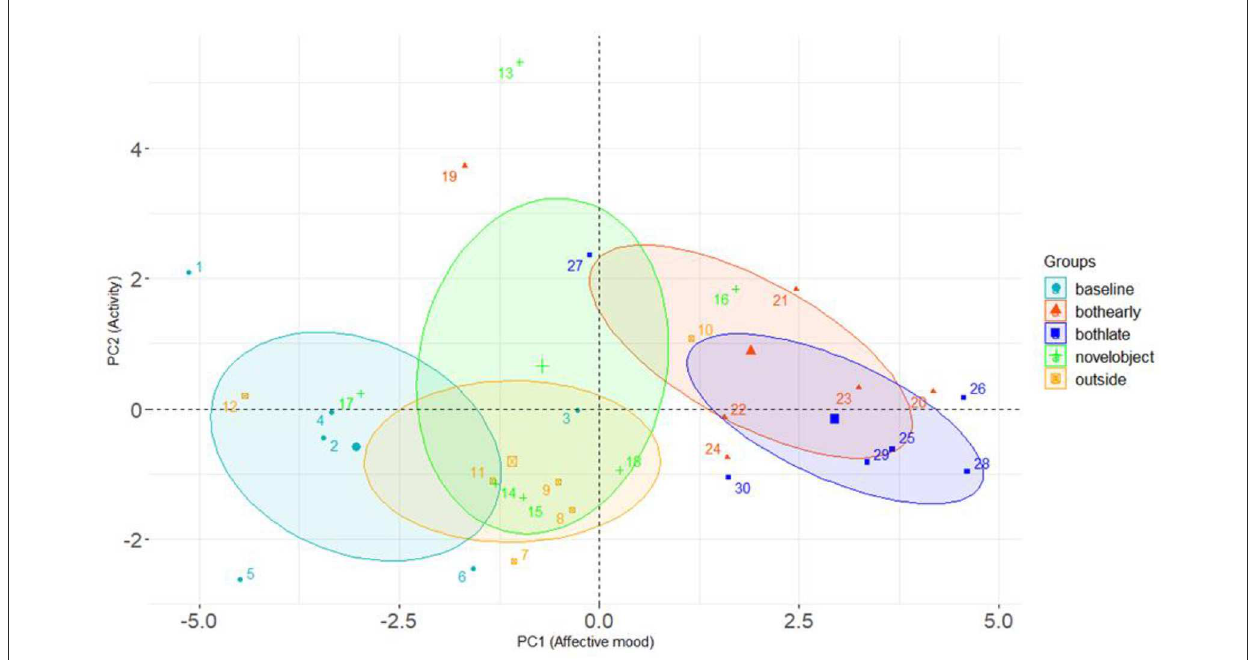
FIGURE5 Group 1: Biplot displaying all QBA assessment scores in terms of PC1 and PC2. Each separate point displays one assessment date. Points are coded per treatment period [baseline, novel object, outside, both resources (early) and both (late)] as indicated on the plot. Group means are in bold and ellipses indicate the 95% confidence intervals of the group